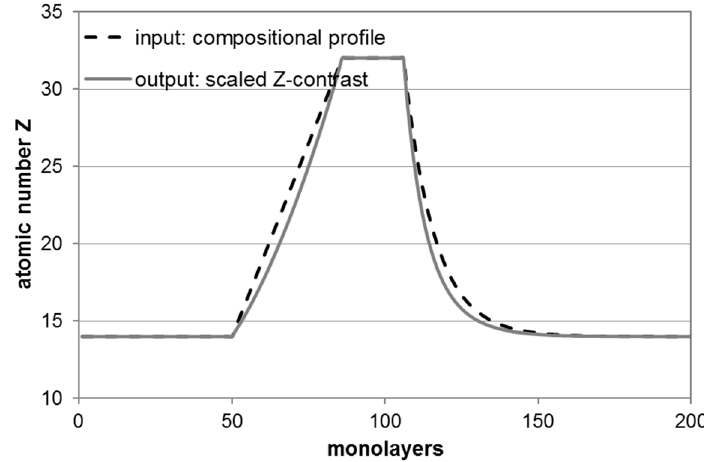
Figure 6. Simulation of compositional profiles through a Ge quantum well (QW) structure with (from left to right) 7 nm Si, 4.9 nm linearly graded SiGe, 2.8 nm Ge, 13 nm SiGe with exponential tail (1/e length: L = 1.4 nm, monolayer: d ML = 0.14 nm).